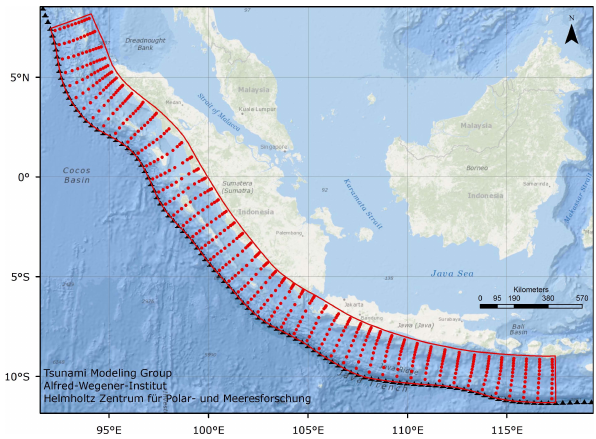
Fig. 13. Tsunami scenario repository for GITEWS. Scenarios for up to ten different magnitudes M w = 7 . 2 , 7 . 4 ,..., 9 . 0 are calculated at each of the 528 positions marked with red dots, resulting in 3470 scenarios in